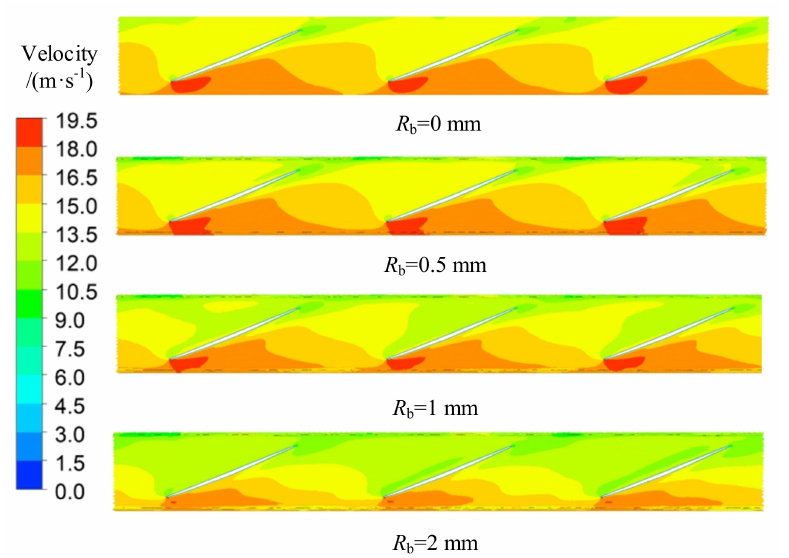
Figure 11. Velocity distribution in cylindrical section of impeller under different R b at Q = 1.0 Q des ( Span =